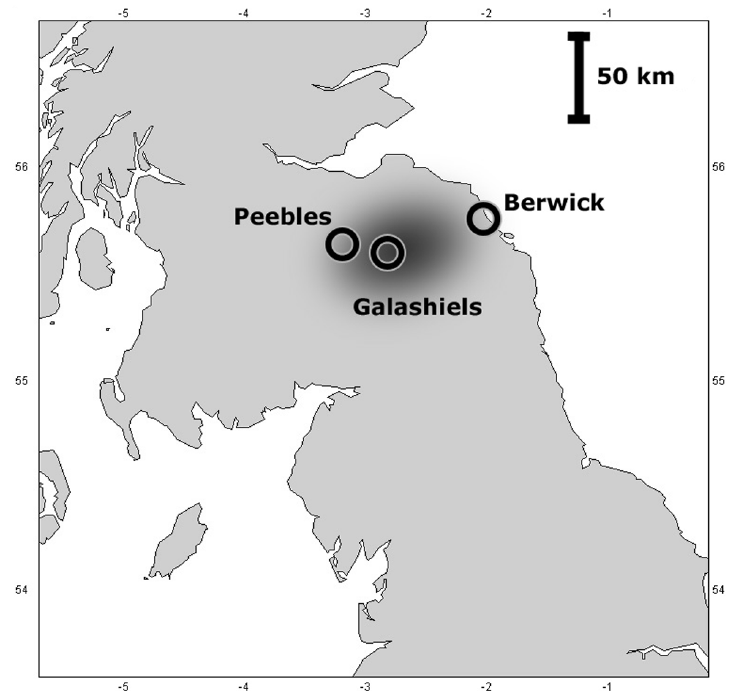
Fig. 5. Approximate felt area for the 27 April 1650 Galashiels